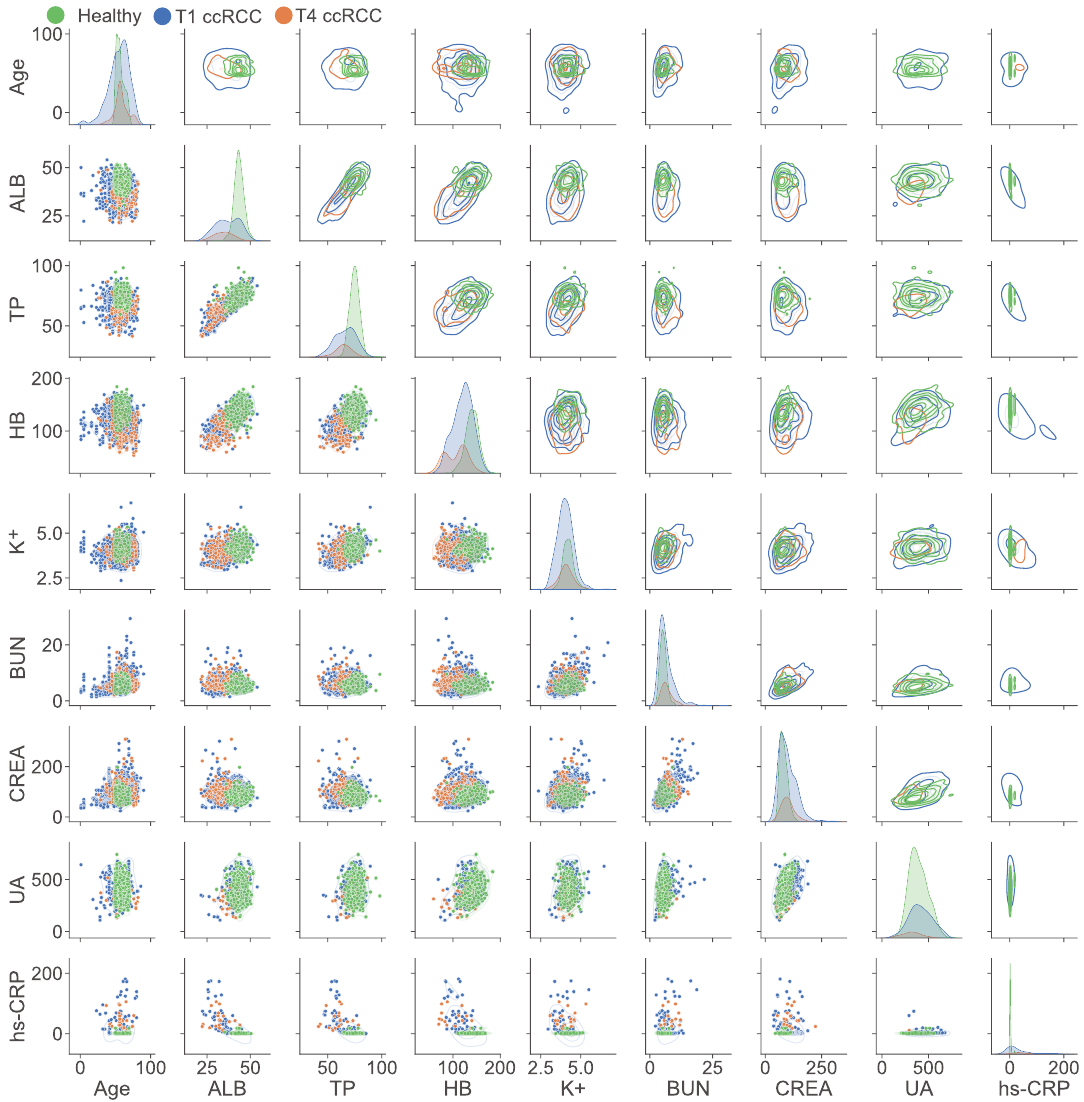
Figure 5. The paired relationship between biochemical indicators with ccRCC patients and healthy population. Correlation analysis of pairwise parameter combinations of the eight indicators was conducted to visualise the distribution differences between cancer patients and healthy